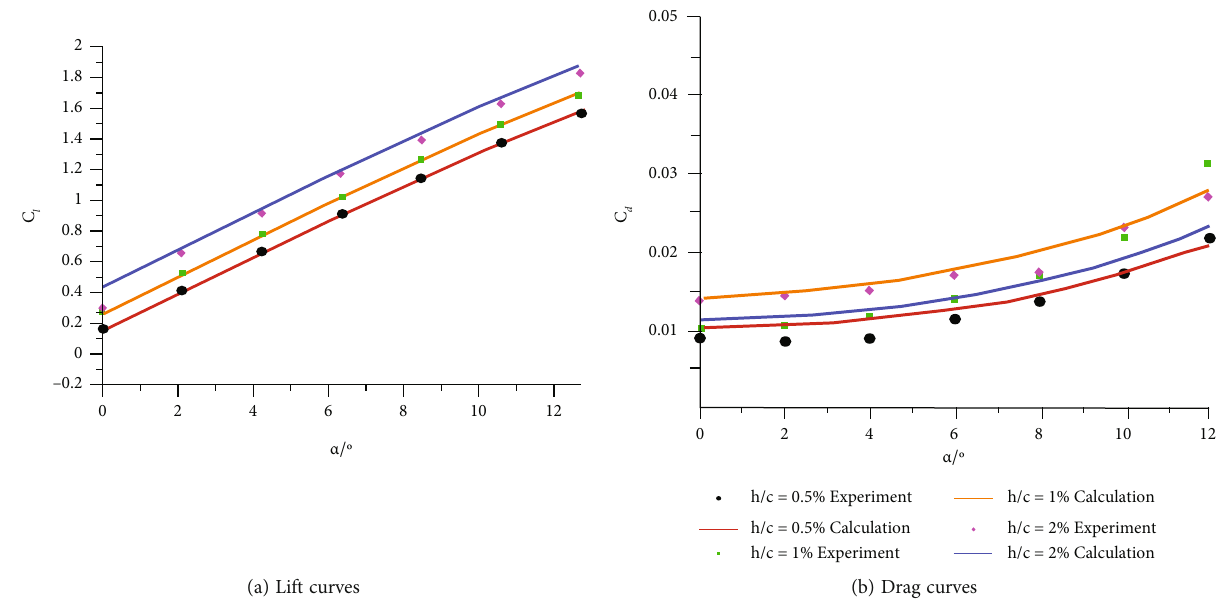
Figure 5: Aerodynamic coe ffi cients of a NACA 0012 wing with di ff erent GFs.